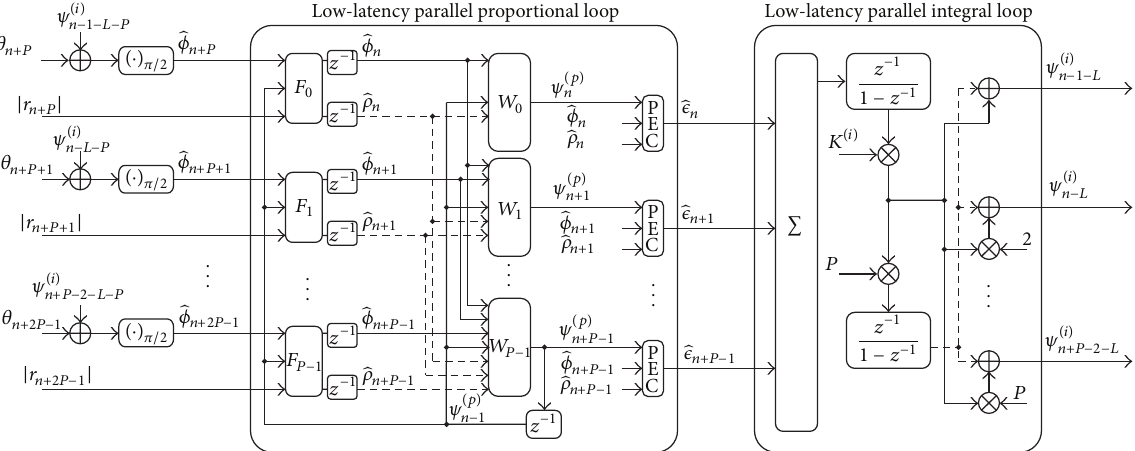
Figure 15: Implementation of the low latency parallel type II DPLL.